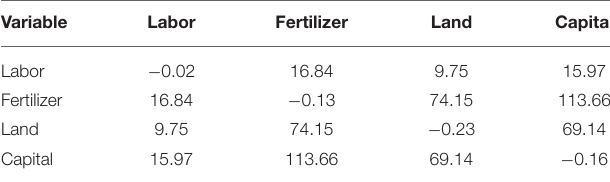
TABLE 5 | Allen’s partial elasticity of substitution (Mean values). Variable